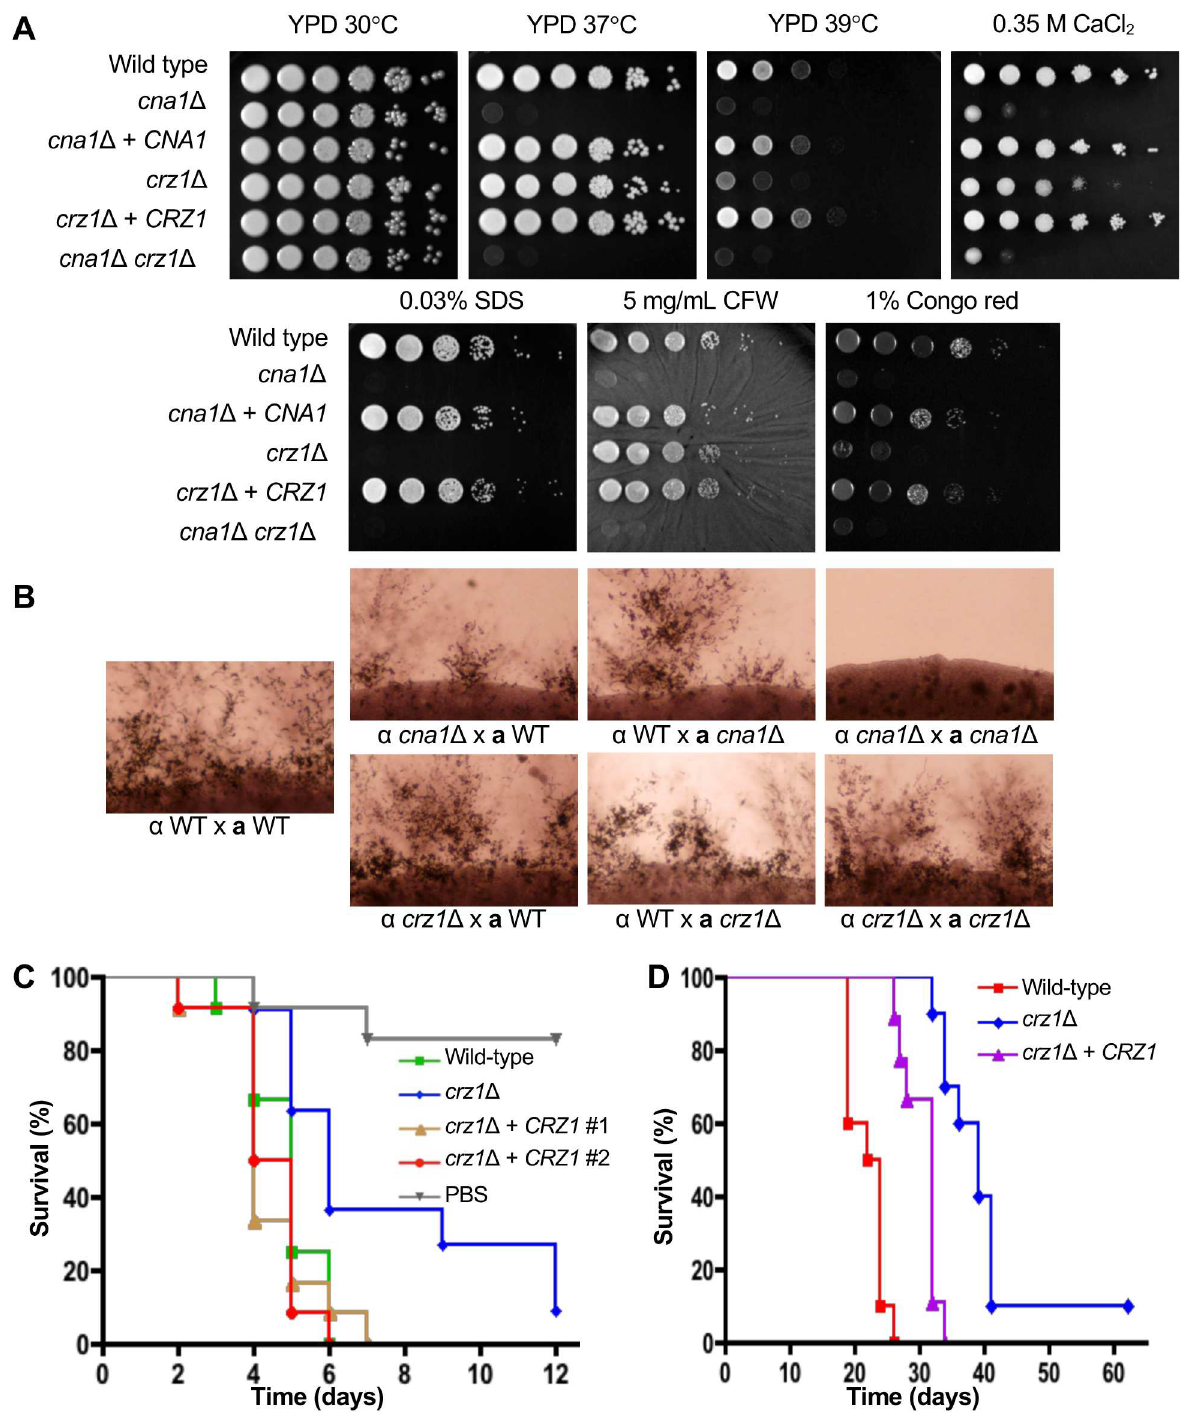
Fig 2. Deletion of CRZ1 confers partial phenotypes in comparison to wild-type and cna1 Δ mutant. (A) Wild-type (H99), cna1 Δ (KK1), crz1 Δ (AFA3-3) mutants and their respectivecomplemented strains (KK5 and AFA3-3-17), and the cna1 Δ crz1 Δ doublemutant strain (XW245) were grown in YPD media, washed,and resuspended in PBS. Five 10-fold serial dilutionsof each strain were spotted on YPD solid media, with the variousadditivesas listed and incubatedat 30˚C for 48 h, unless otherwisestated. Strains were incubatedat 39˚C for 72 h before imaging. CFW: calcofluor white. (B) Wild-type (H99 and KN99 a ), cna1 Δ (KK1 and KK8), and crz1 Δ (AFA3-3 and AFA1-4) strains of opposite mating type were grown in YPD media, washed, and resuspended in PBS. Equal cell numbersof opposite mating types were mixed and spotted on MS media. Mating assays were incubatedat room temperature in the dark for 12 days and